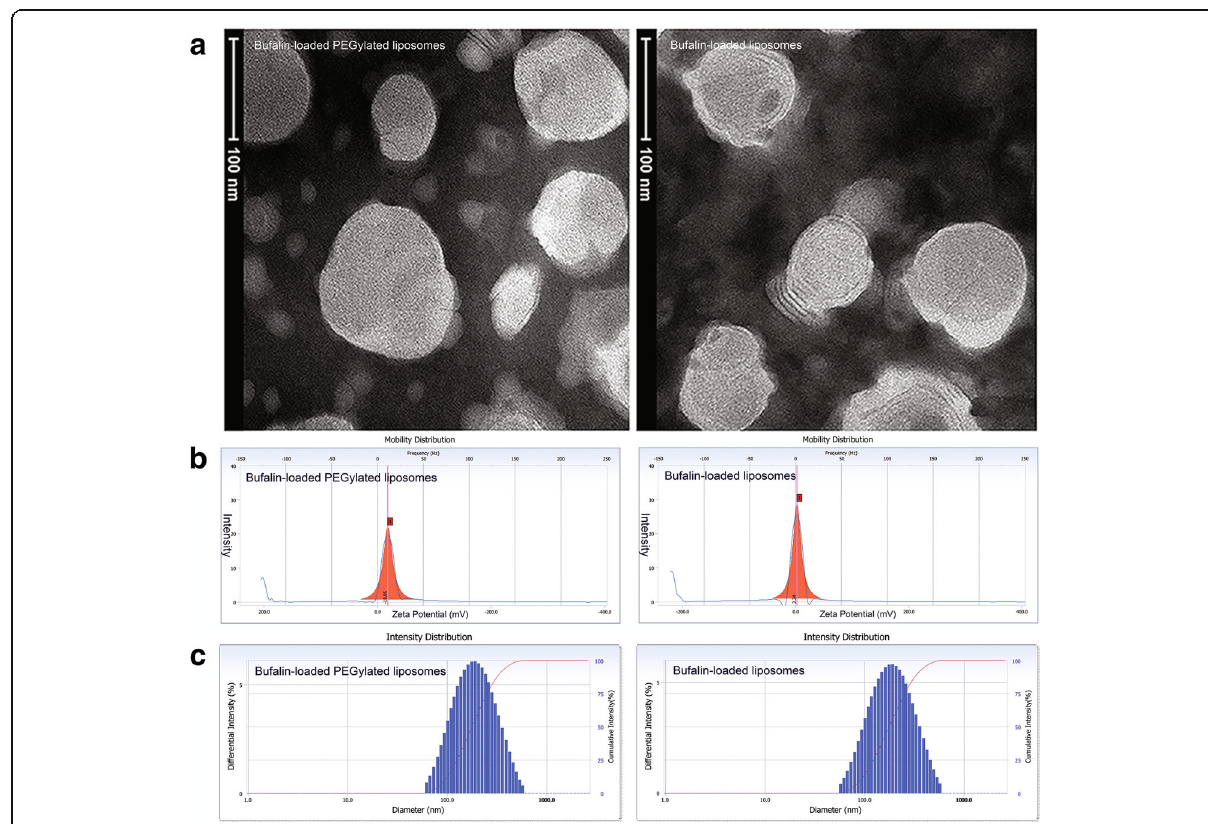
Fig. 1 Physicochemical properties of bufalin-loaded liposomes and bufalin-loaded PEGylated liposomes. a TEM images of bufalin-loaded liposomes and bufalin-loaded PEGylated liposomes with nearly spherical or oval shape. b The typical particle size and distribution of bufalin- loaded liposomes and bufalin-loaded PEGylated liposomes as measured by dynamic light scattering. c The typical surface zeta potential of bufalin-loaded liposomes and bufalin-loaded PEGylated liposomes